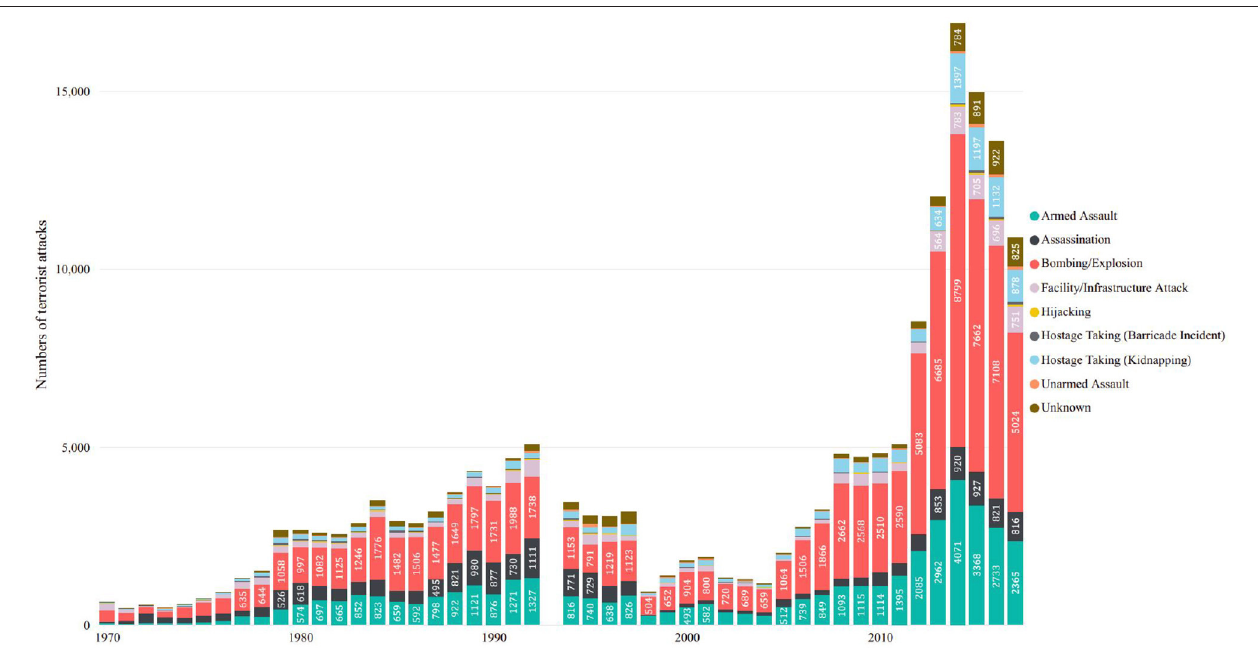
FIGURE 1 | Global terrorism trend and proportion of different attack types (Data source: GTD, 1970-2017, attack type statistics using GTD’s variable attacktype 1_ txt ).